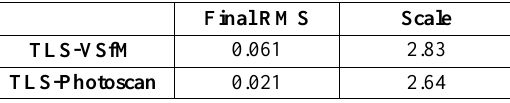
For subset one (Figure 6(a)), the standard deviation for the Gauss fit in the case of Photoscan point cloud was 0.00414. The standard deviation for the Gauss fit in the case of Photoscan point cloud was 0.00374, for subset two ((Fig 6(b)).